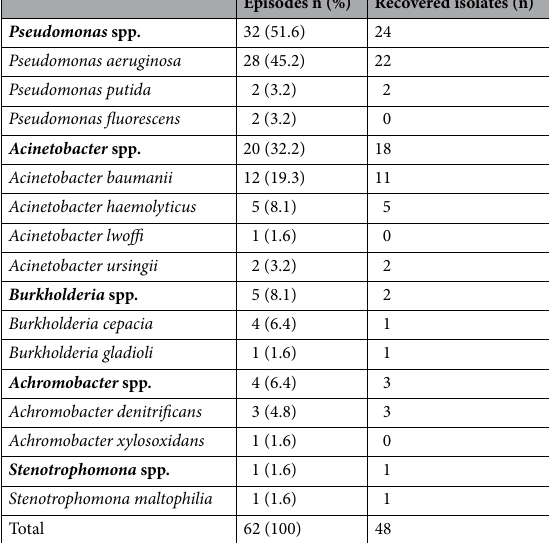
Episodes n (%) Recovered isolates (n)